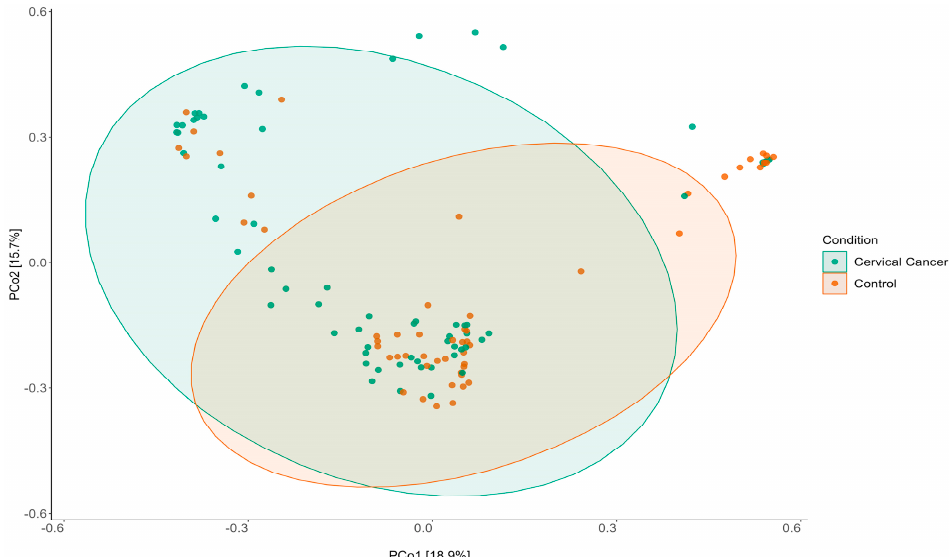
Figure 6. PCOA plots of β diversity of vaginal microbiota based on Bray − Curtis distance measure. The ellipses represent the two groups. The cervical cancer is shown in green color, whereas the healthy control group is shown in orange color. The coalition network can be used to depict the associativity between microorgan- isms present within a group or a community. The PCoA plot indicates a significant dis- tinction among the vaginal microbial communities of cervical cancer and healthy control